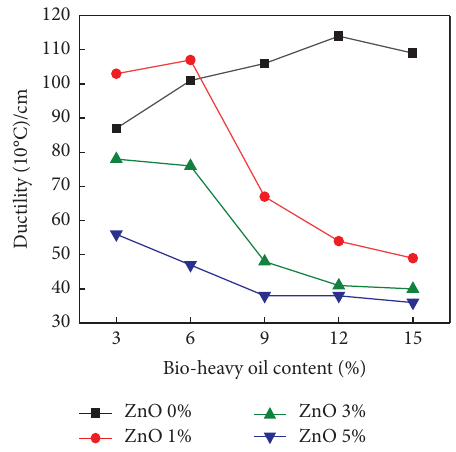
Figure 4: Ductility under diferent bio-asphalt contents.